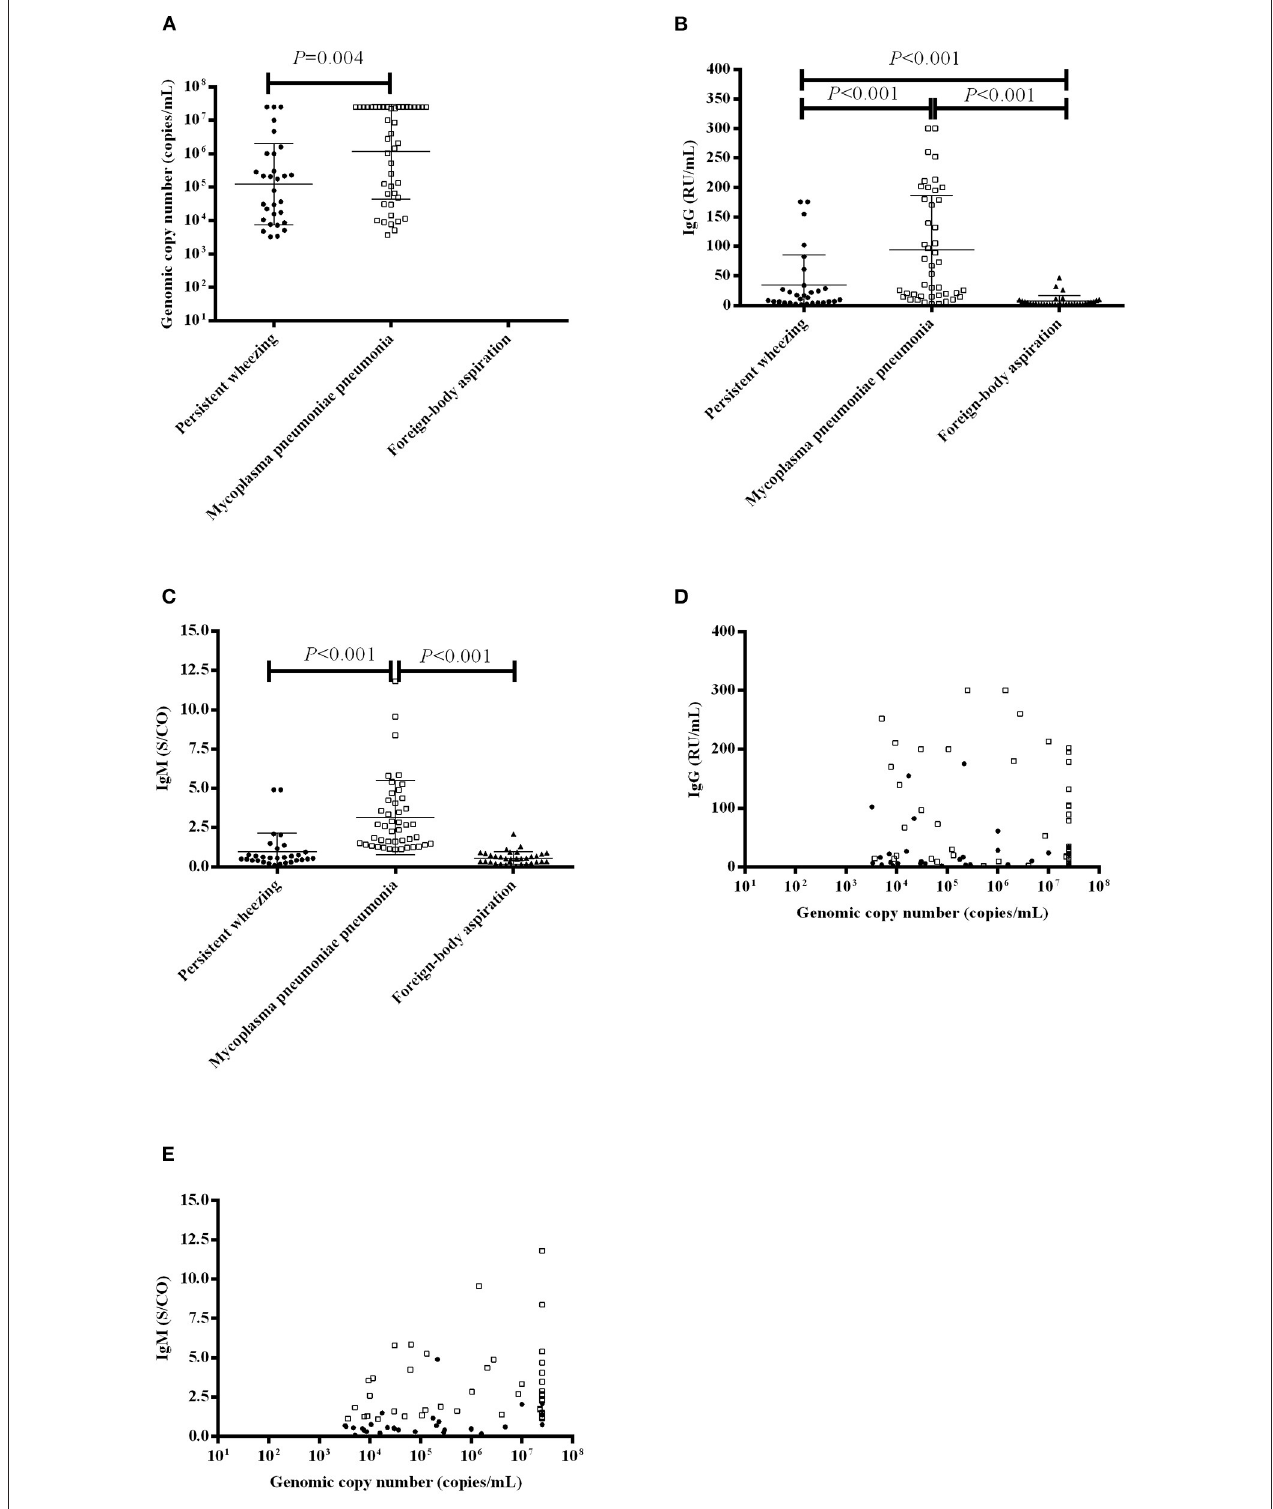
FIGURE 2 | MP DNA loads and MP antibody levels in patients with PW, MPP and FBA. (A) MP DNA loads in the BALF of patients with PW, MPP and FBA; (B) Serum IgG levels in patients with PW, MPP and FBA; (C) Serum IgM levels in patients with PW, MPP and FBA; (D) Correlation of MP DNA loads and serum IgG levels; and (E) Correlation of MP DNA loads and serum IgM levels. Each dot, box and triangle indicates an individual patient.